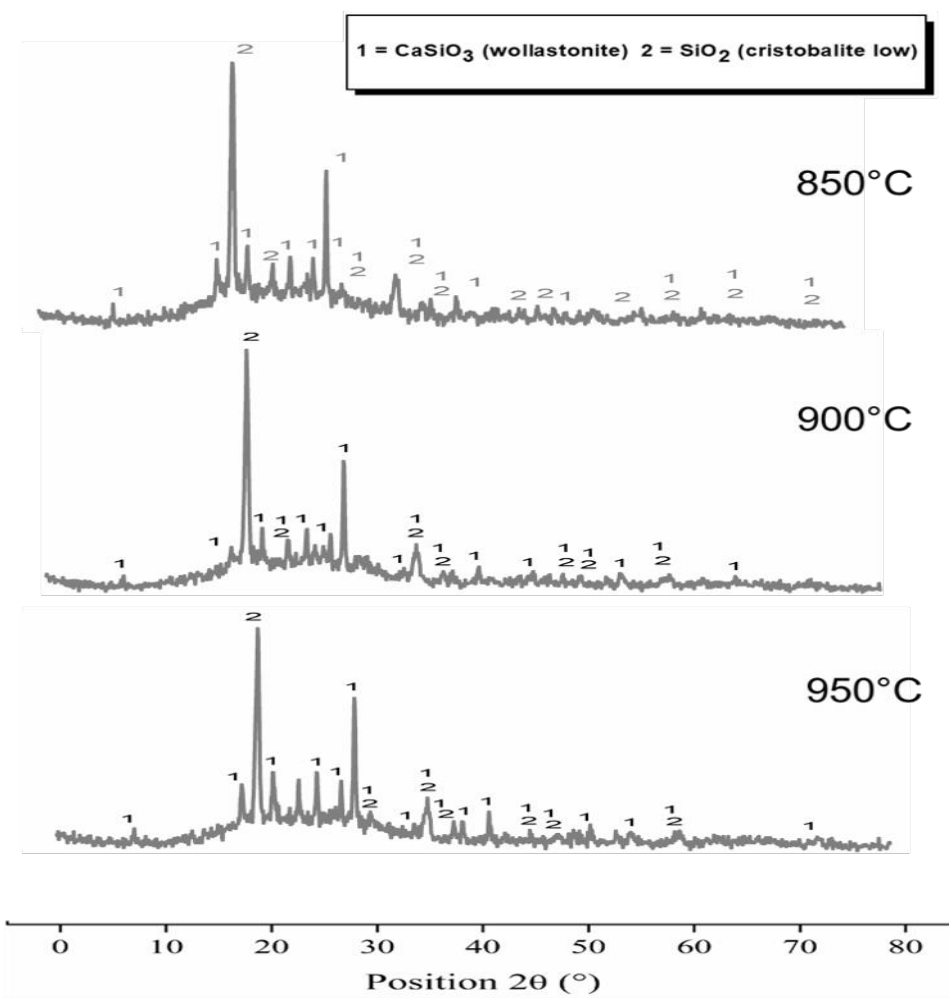
Figure 2. XRD patterns of samples sintered at 850, 900 and 950 °C.